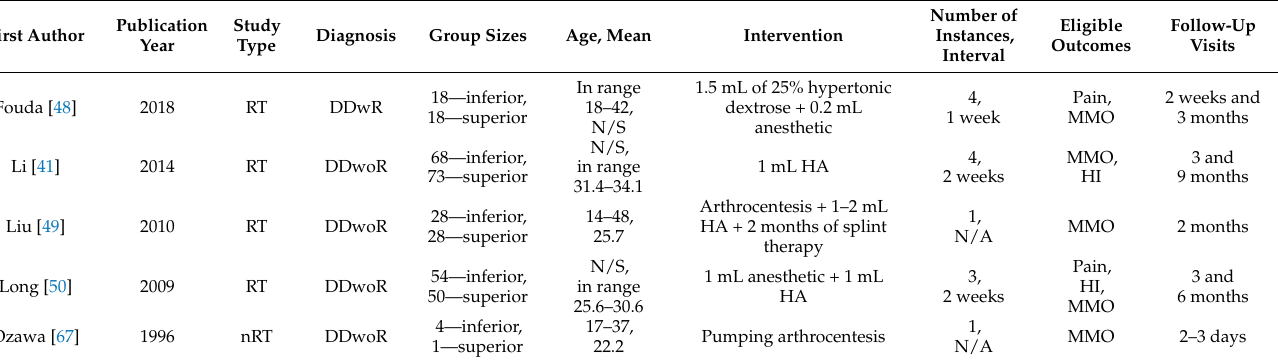
Table 2. Study characteristics.